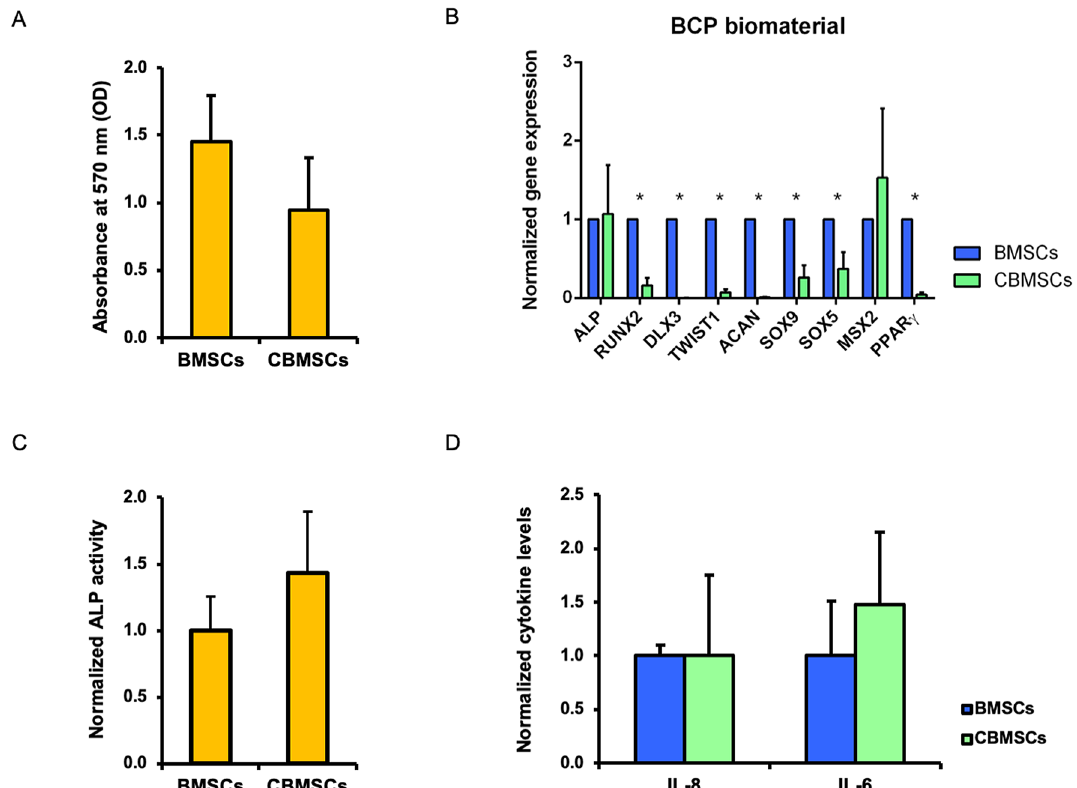
Figure 4. Gene expression profiles and secretion properties of BMSCs and CBMSCs cultured on BCP biomaterial. ( A ) Histogram showing optical density (OD) at 570 nm as Mean ± standard deviation (SD). ( B ) Histogram showing gene expression of BMSCs and CBMSCs as Mean ± standard error of the mean (SEM) and normalized to BMSCs. ( C ) Histogram showing ALP activity as Mean ± SD and normalized to BMSCs. ( D ) Histogram showing levels of secreted interleukin (IL)-8 and IL-6 as Mean ± SD and normalized to BMSCs. Statistical analysis was by unpaired Student’s t -test. *Significant difference between MSCs of different tissue